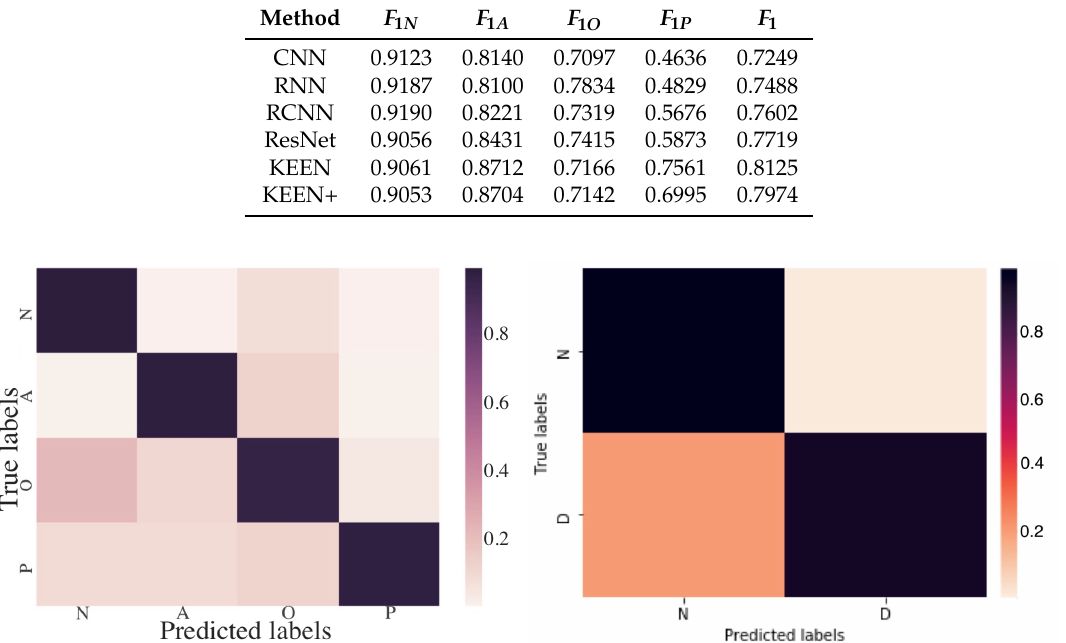
Figure 7. Confusion matrix of KEEN.